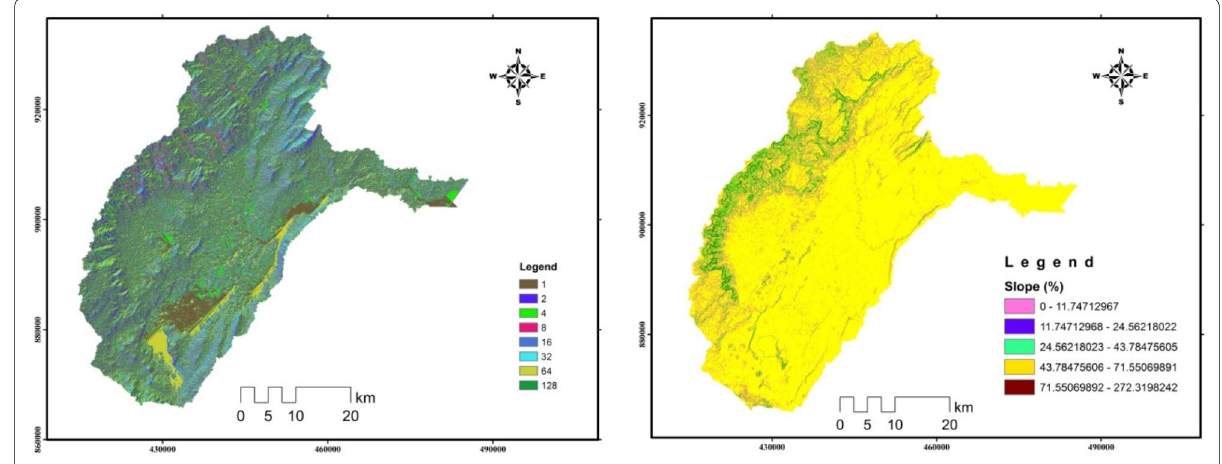
Fig. 9 Flow length and Slope map of Meki watershed (Source: